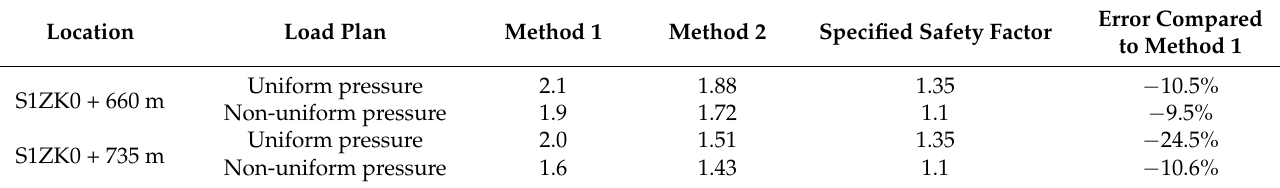
Table 8. Comparison of the calculation results of the two methods.